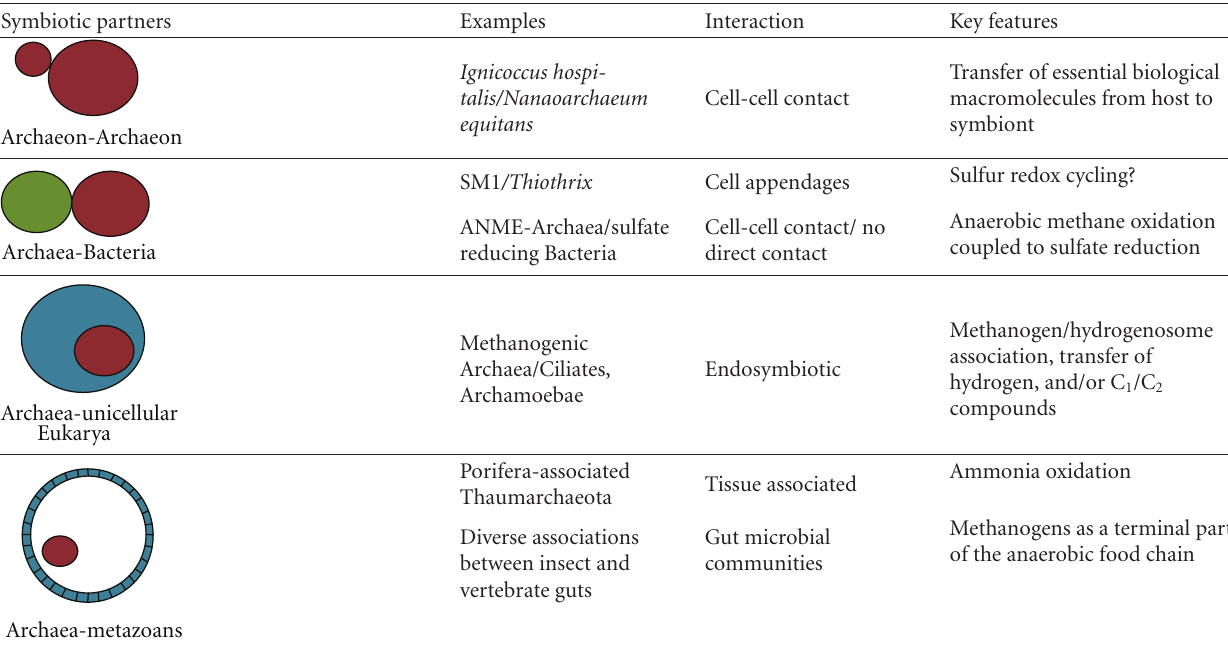
Table 1: Some examples for symbioses between Archaea and other organisms (red Archaea, green Bacteria, blue-unicellular Eukarya, and